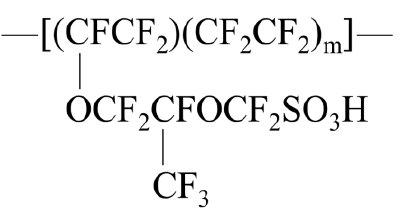
Figure 8. Structural formula of the Nafion resin.